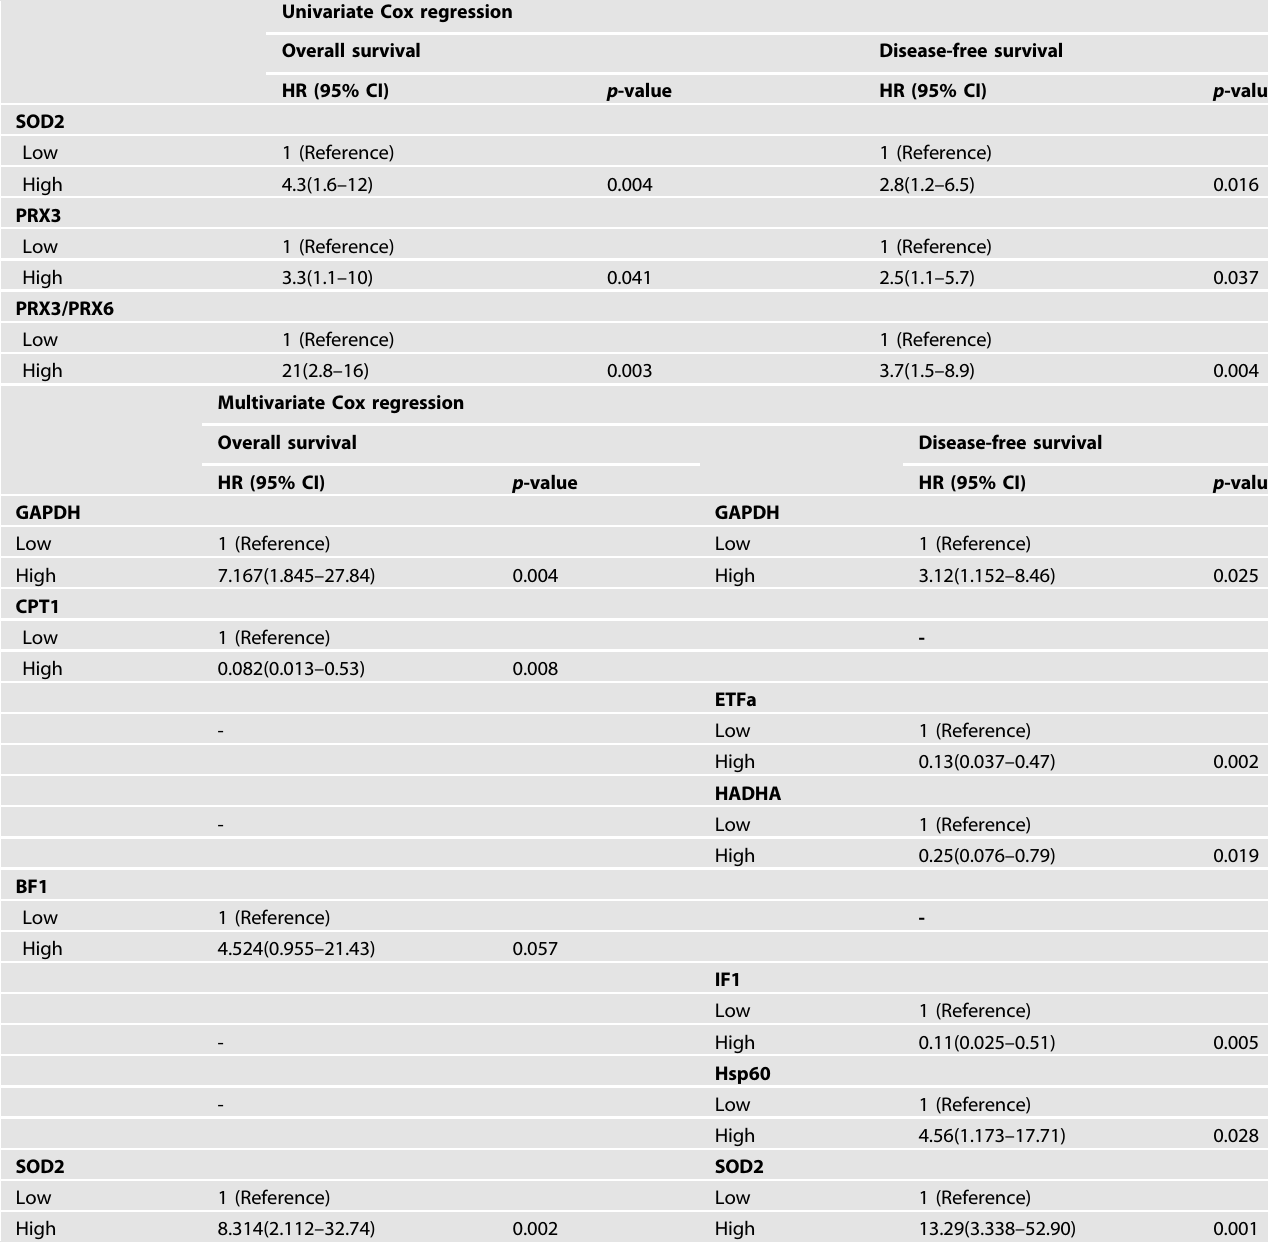
(Table 1). The ratio between IF1 and its target on the ATP synthase, β -F1-ATPase (Fig. 2a), is higher in carcinomas and predicted better OS and DFS for LUAD patients (1.69 ± 0.30 ( n = 52) versus 0.50 ± 0.02 ( n = 17), p < 0.01 for good or bad prognosis groups, respectively) (Fig. 2b; Table